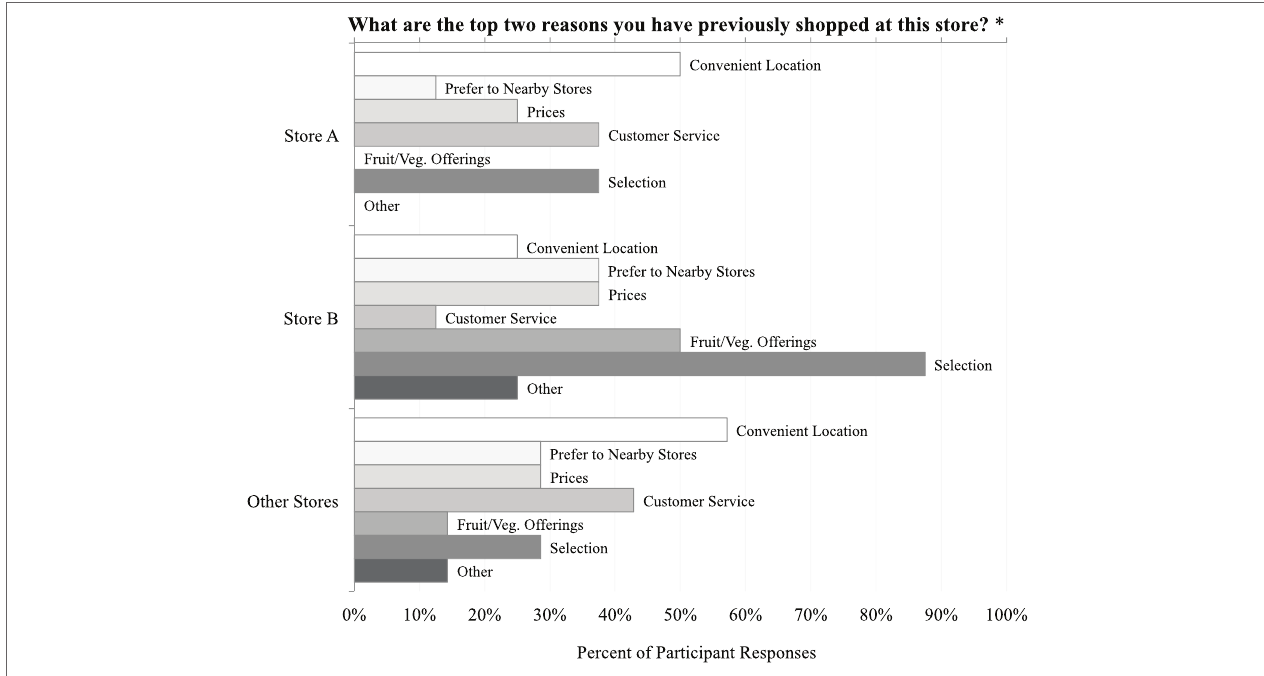
FiguRE 1 | Factors for choosing a store for grocery shopping. *Some participants gave more than two reasons when responding to this question; thus, results are presented as a percent of participant responses about Store A, Store B, and Other Stores. Survey question